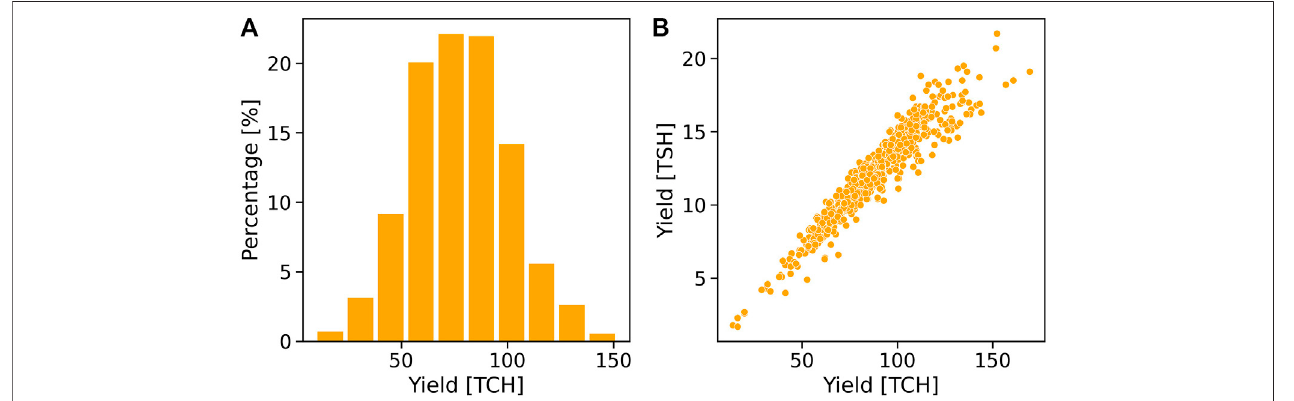
FIGURE 1 | (A) Distribution of sugarcane yield for season 2018-2019 and 2019-2020. (B) Comparison sucrose yield and sugarcane yield ( r (cid:2) 0.95).